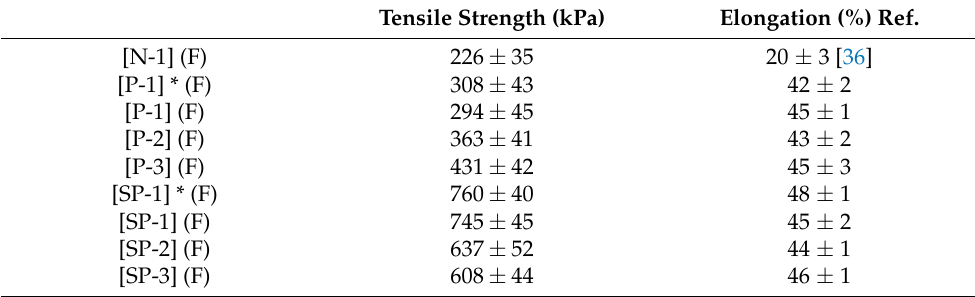
Table 2. The mechanical properties of the (TPS/SA/PEG)/PBAT composite foams. Tensile Strength (kPa) Elongation (%) Ref. [N-1]